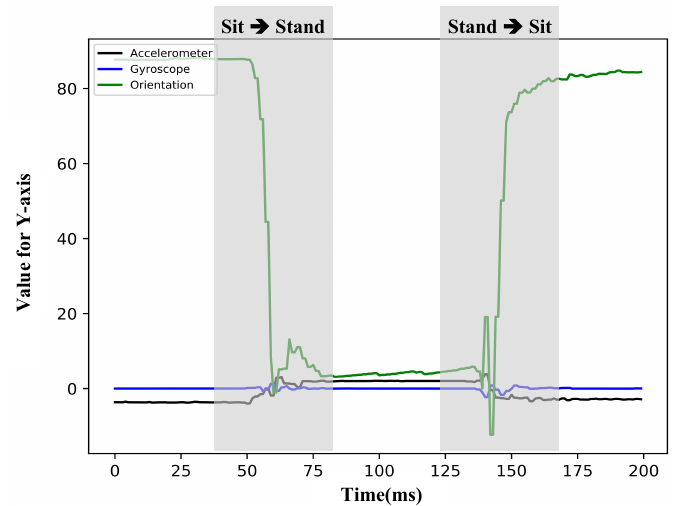
Figure 3. Change in the Y-axis for each type of sensory data.